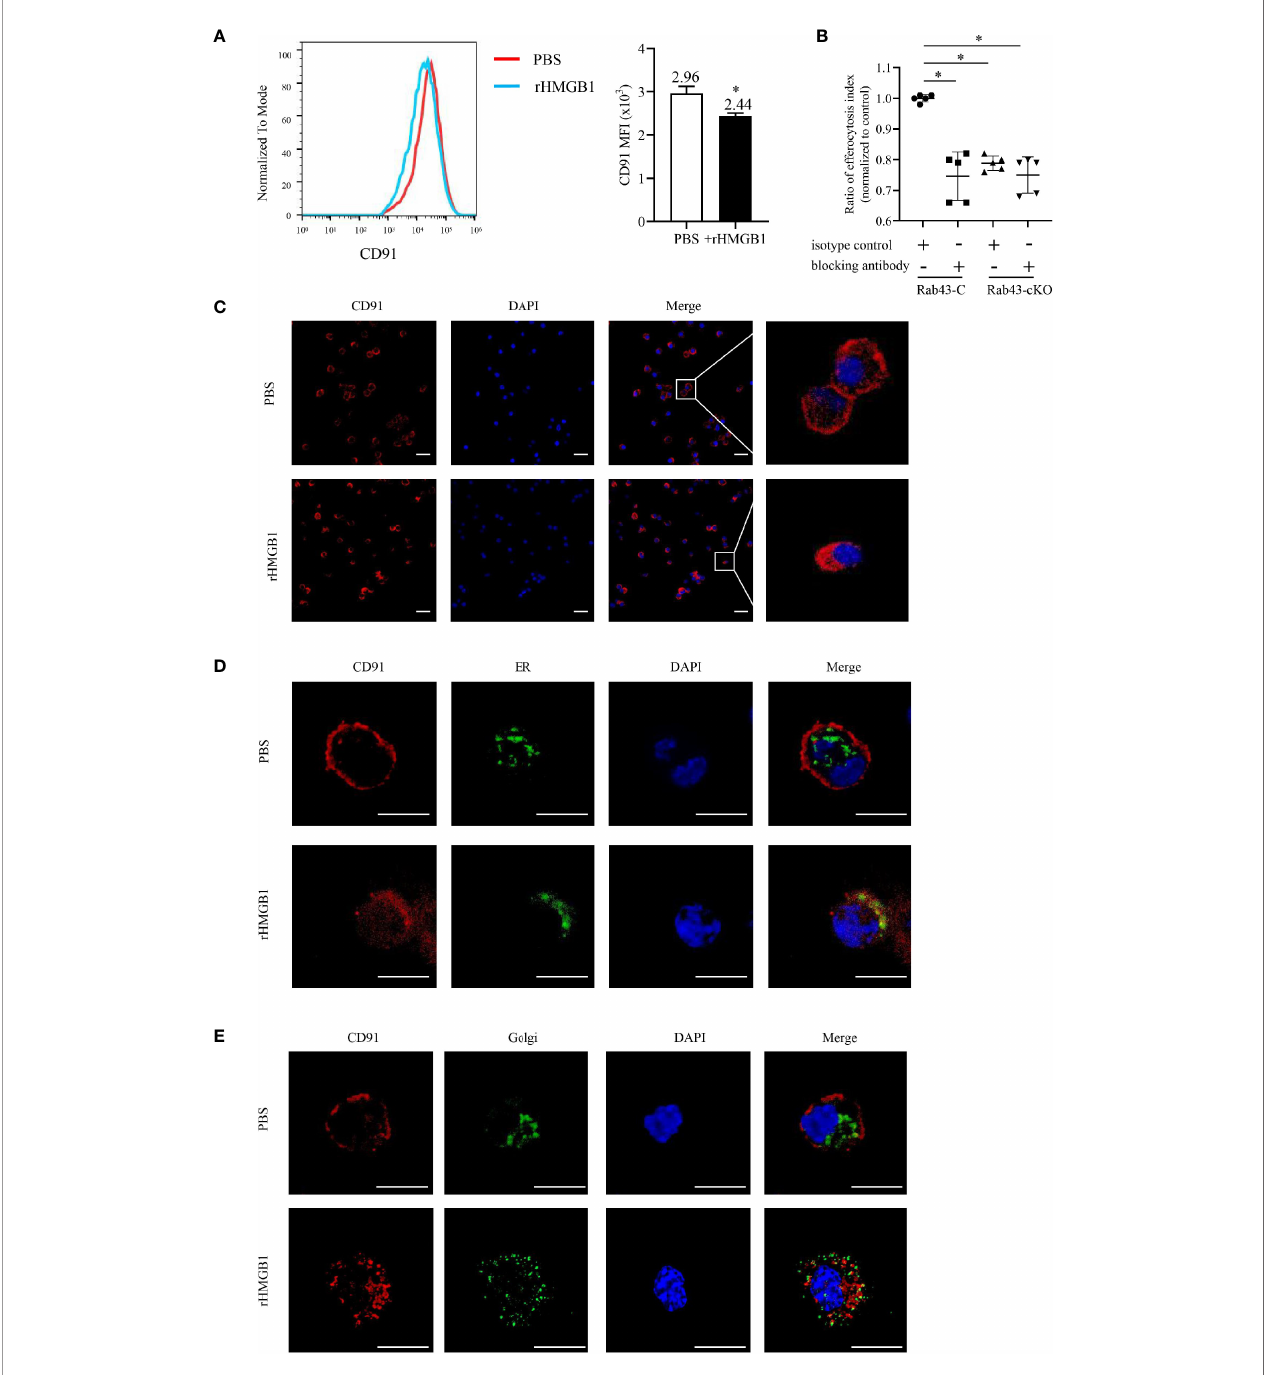
FIGURE 4 | rHMGB1 suppressed CD91 expression on the cell surface. The bone marrow-derived macrophages (BMDMs) were treated with 2 m g/ml rHMGB1 for 12 h. (A) The CD91 level on the cell surface was detected using fl ow cytometry. * P < 0.05 versus the phosphate-buffered saline (PBS)-treated group. (B) Rab43-C or Rab43-cKO BMDMs were incubated with CD91-blocking antibody or IgG for 1 h, and then engulfment of apoptotic cells was measured by fl ow cytometry. * P < 0.05 versus the Rab43-C/IgG group. (C) Confocal laser-scanning microscopy (CLSM) to determine the subcellular localization of CD91. The BMDMs were stained with the anti-CD91 antibody. Red, CD91; blue, DAPI. Scale bars = 10.0 m m. (D) Co-localization of endogenous CD91 with the ER marker Calnexin. The BMDMs cultured in glass-bottom dishes were stained with anti-CD91 antibody and anti-Calnexin antibodies. Red, CD91; green, Calnexin; blue, DAPI. Scale bars = 10.0 m m. (E) Co-localization of endogenous CD91 with the Golgi body. The BMDMs were fi xed with 4% formaldehyde solution for 10 min. A suf fi cient volume of Dual Detection Reagent was added to cover the monolayer cells (1:100 dilution). After blocking for 1 h, the cells were stained with anti-CD91 antibody. Red, CD91; green, Golgi body; blue, DAPI. Scale bars = 10.0 m